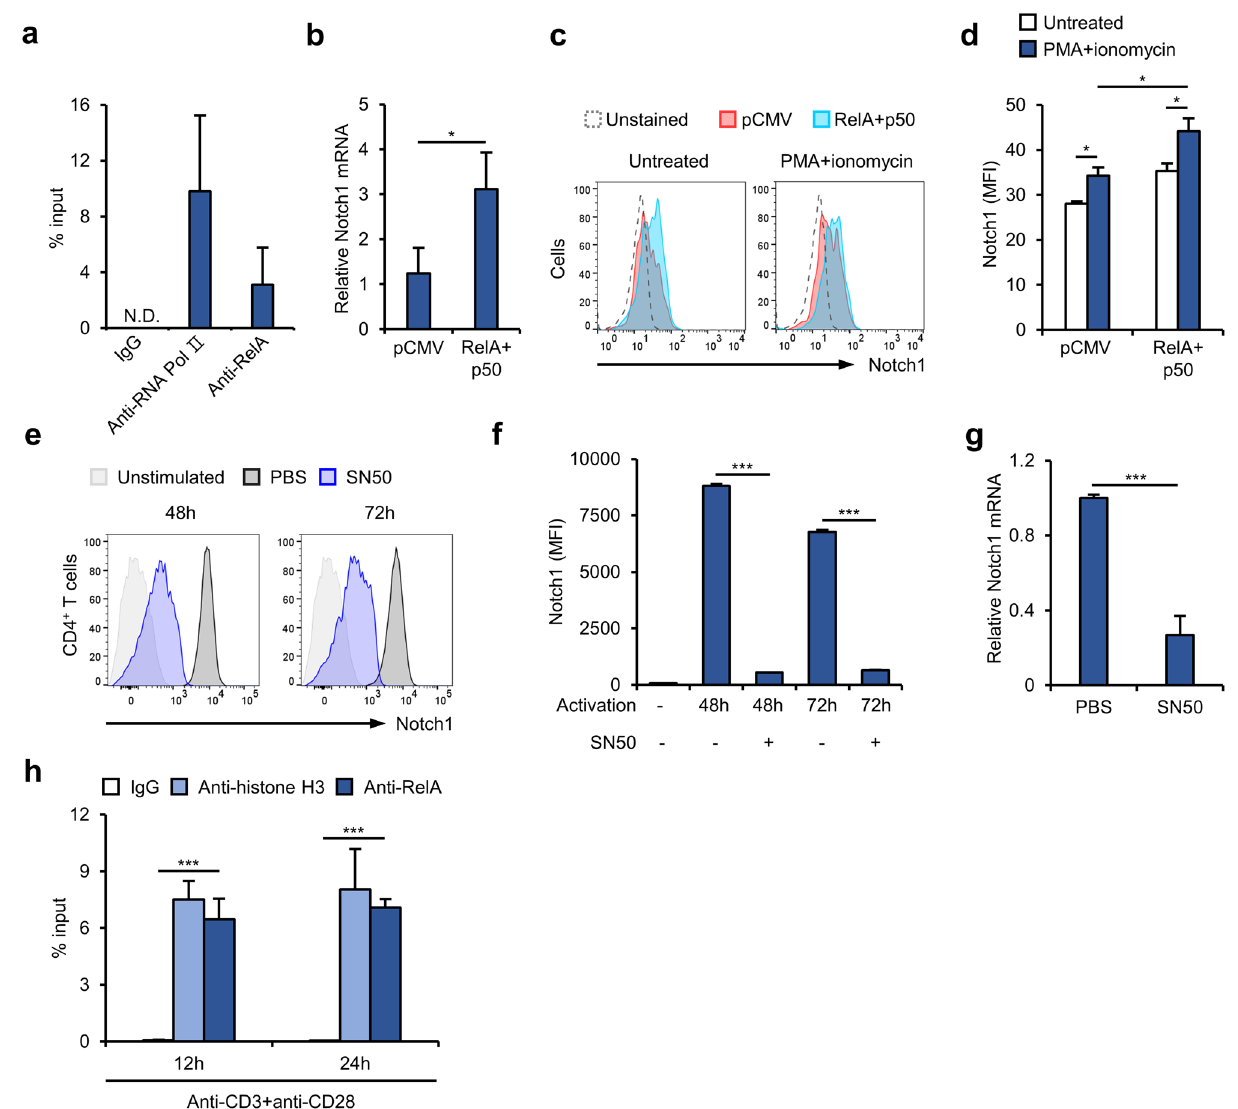
Figure 4. Upregulation of Notch1 transcription by NF-κB in activated T cells. ( a ) Jurkat T cells activated with PMA/ionomycin were subjected to ChIP-qPCR analysis to detect chromatin containing the Notch1 -300–- 270 region. N.D., not determined. ( b ) Quantitative real-time PCR for Notch1 mRNA expression in RelA and p50-overexpressing Jurkat T cells. ( c, d ) Flow cytometry for surface Notch1 expression in activated Jurkat T cells overexpressing RelA or p50. ( e , f ) Flow cytometry analysis of primary CD4 + T cells activated in the presence of 100 μM SN50 or PBS for the indicated times. ( g ) Quantitative real-time PCR of Notch1 mRNA from activated primary CD4 + T cells cultured for 48 h in the presence of 100 μM SN50 or PBS. ( h ) ChIP-qPCR analysis of primary CD4 + T cells, activated with anti-CD3 and anti-CD28 antibodies for the indicated times, to detect chromatin containing the Notch1 − 300 to − 270 region. Data are presented as the mean ± SD. * P ≤ 0.05, ** P ≤ 0.01, and *** P ≤ 0.001 (Student’s t